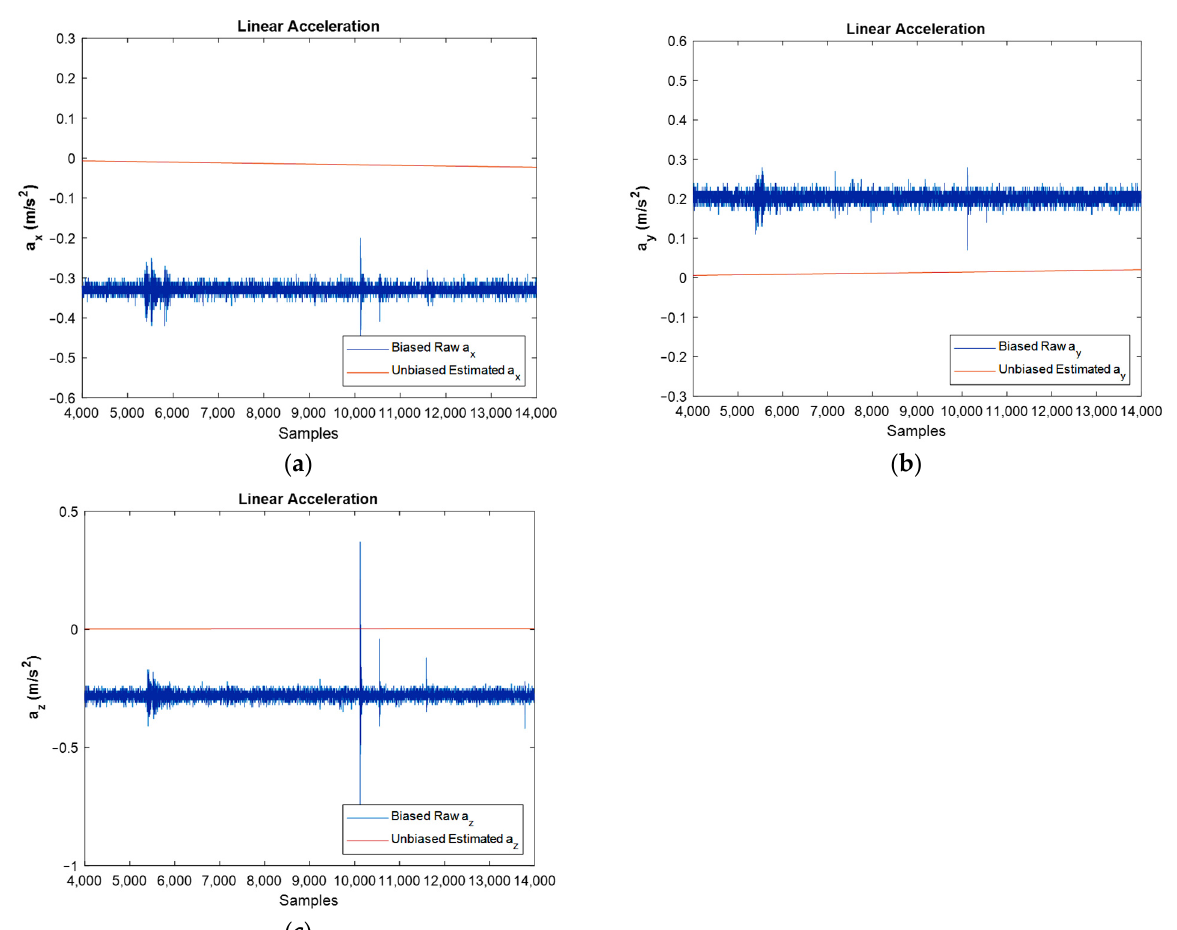
Figure 9. Estimated unbiased linear acceleration for stationary IMU in x , y , and z directions against biased raw one: ( a – c ), respectively.